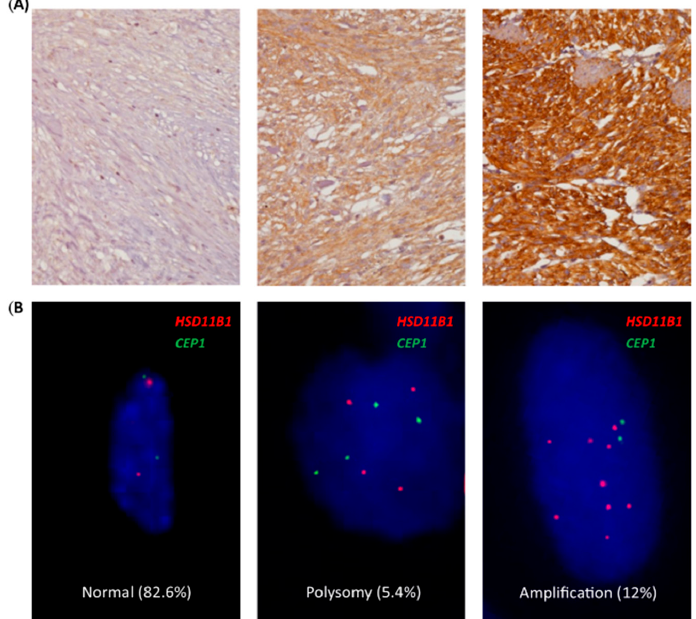
Figure 2. Independent validation to confirm clinical relevance of high hydroxysteroid 11-beta dehydrogenase-1 (HSD11B1) expression and HSD11B1 copy-number gain (CNG) in tissue microarrays. ( A ) Representative samples of low-risk (left upper), intermediate-risk (middle upper), and high-risk (right upper) gastrointestinal stromal tumors (GISTs) stained with anti-HSD11B1 exhibited no, diffuse moderate, and diffuse strong cytoplasmic reactivity, respectively; ( B ) By using the reference probe labeling the centromeric sequence of chromosome 1 (green), the locus-specific probe that targets HSD11B1 on 1q32.2 (red) was distinguishable as normal status (left lower; 82.6%), polysomy (middle lower; 5.4%), and amplification (right lower; 12%) in 350 cases by fluorescent in situ hybridization (FISH) assay. CEP 1, chromosome 1 centromere